Question: According to this chart, does the measure grow or shrink?
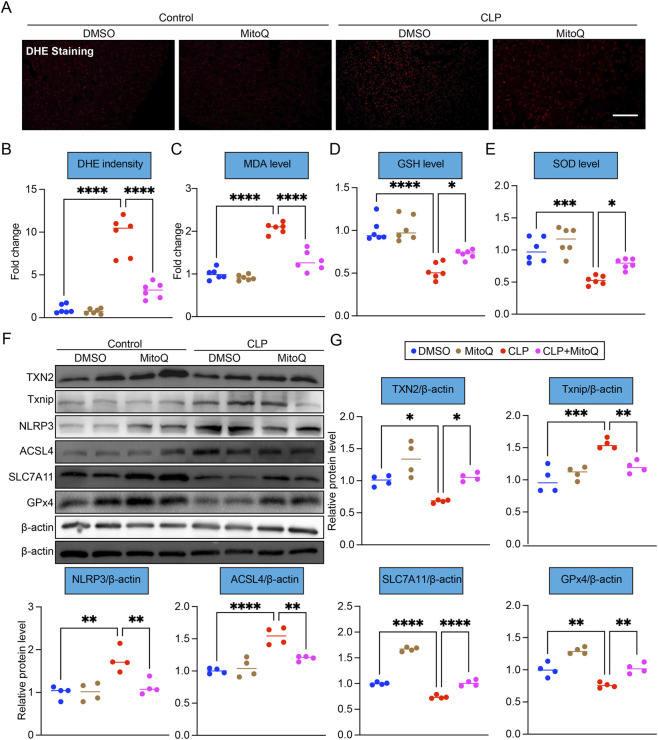
Answer: decreasing